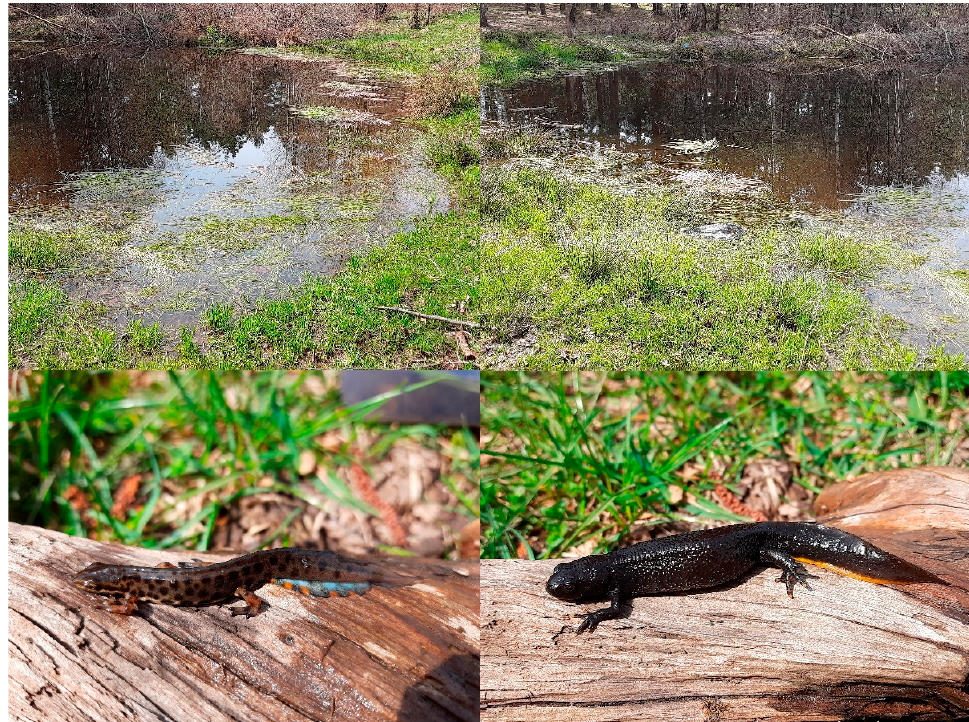
Figure 3. Field observations of spawning of native newts T. cristatus ( lower right corner ) and L. vulgaris ( lower left corner ) in the same temporary seasonal pond without any presence of P. glenii , 29.04.2021, Rivne region, Ukraine; upper part of the picture illustrates the typical spawning water body, shared by both species of newts.